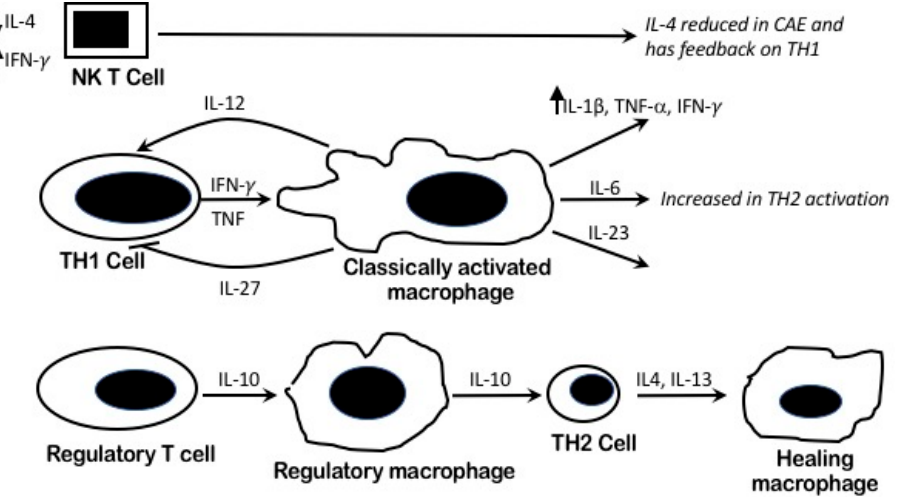
Figure 2. Systematic diagram to illustrate the enhanced pro inflammatory systemic response in CAE. Macrophage activation and the cytokines response. The proposed TH2 pathway activation leads to increased IL-6. However, low IL-4 levels as an outcome of possibly perturbed NK T-cell function lead to poor